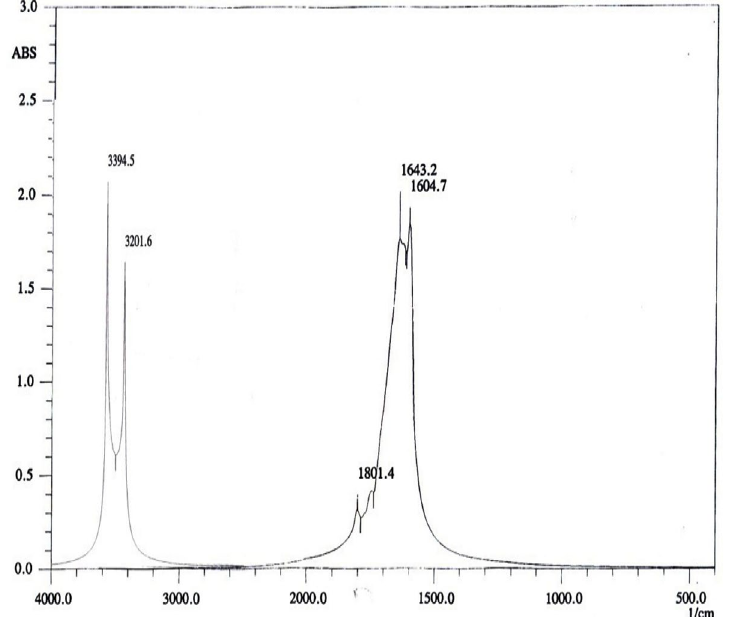
Fig. 4. FTIR measurements for biosynthesized